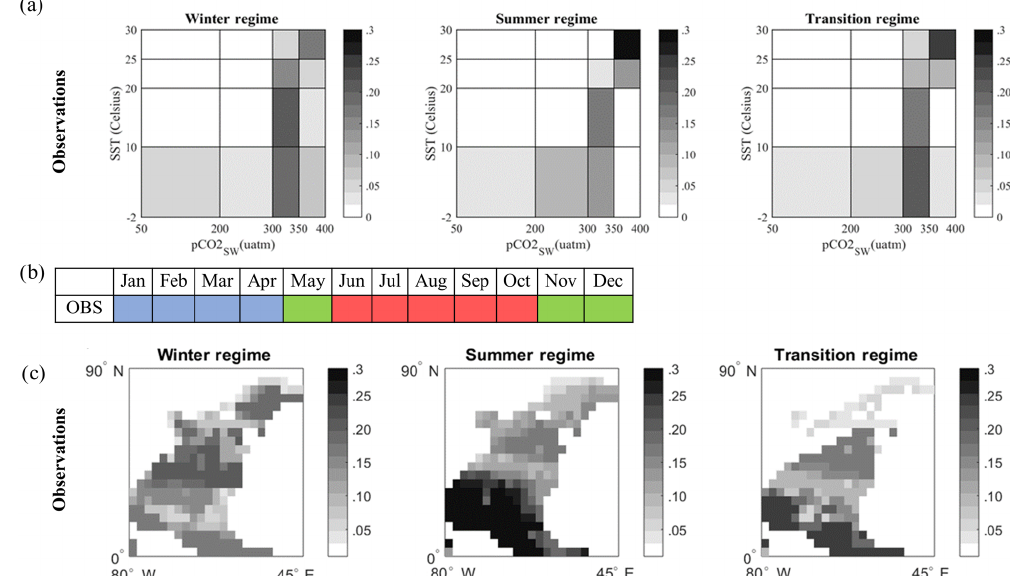
Figure 5. (a) Ocean carbon states (regimes) in observation-based data of the North Atlantic. (b) Monthly attribution of each ocean carbon regime in the Takahashi observational dataset. Temporal attribution is based on the distance of each monthly 2-D histogram to the centroid of each cluster. Each color represents a different regime: blue denotes the cold months’ regime (winter regime), red the warm months (summer regime) and green the May/November–December transition regime, since this is more a mix of the other two. (c) Regional attribution of each regime depicted in (a) . The colors in (c) correspond to the ones in (a) , i.e., to the frequencies of occurrence of each bin (value pair) in the clusters of (a)